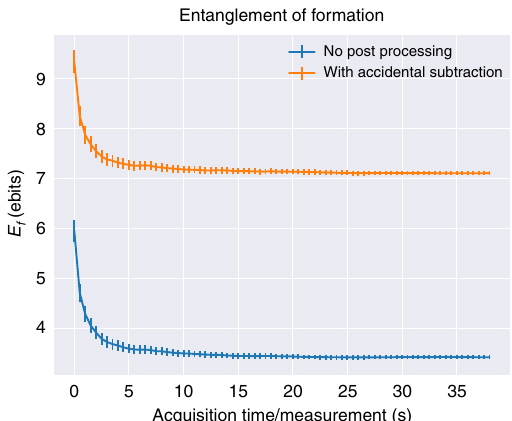
Fig. 3 Entanglement quanti fi cation versus acquisition time. The entanglement of formation E f is given as a function of acquisition time-per- partition for unaltered coincidence data and accidental-subtracted data. Error bars enclosing two standard deviations are determined by propagation of error from photon-counting statistics. We con fi rm the validity of this error analysis strategy via Monte Carlo simulation in Supplemental Material: Monte Carlo error analysis (see Supplemental Fig.